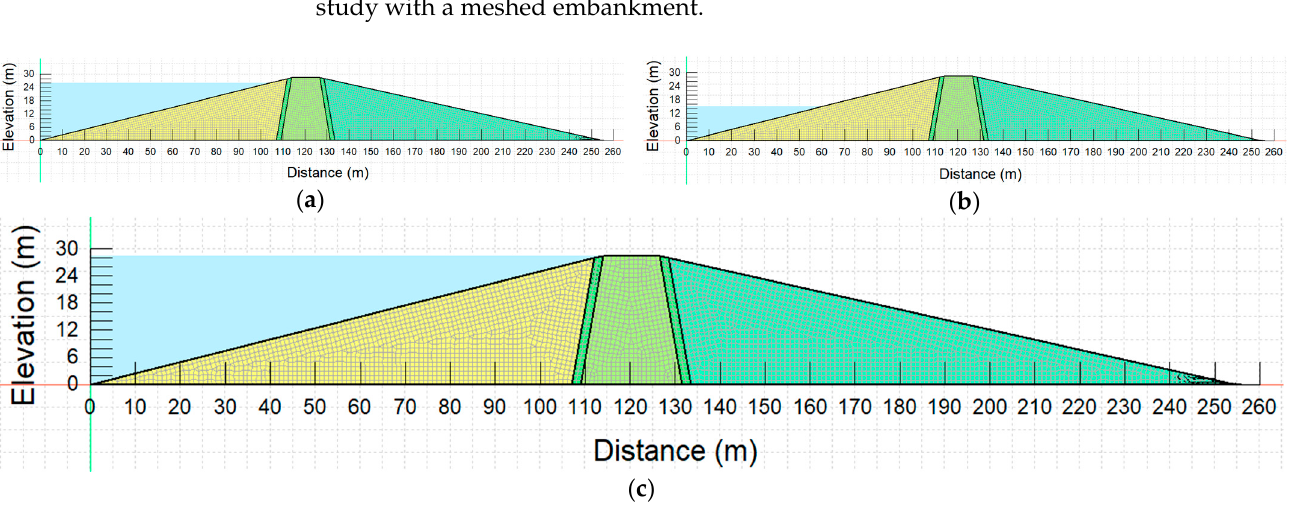
Figure 1. Some of the operating levels investigated in the study: ( a ) normal operating level, ( b ) re- duced operating level, ( c ) embankment height operating level.